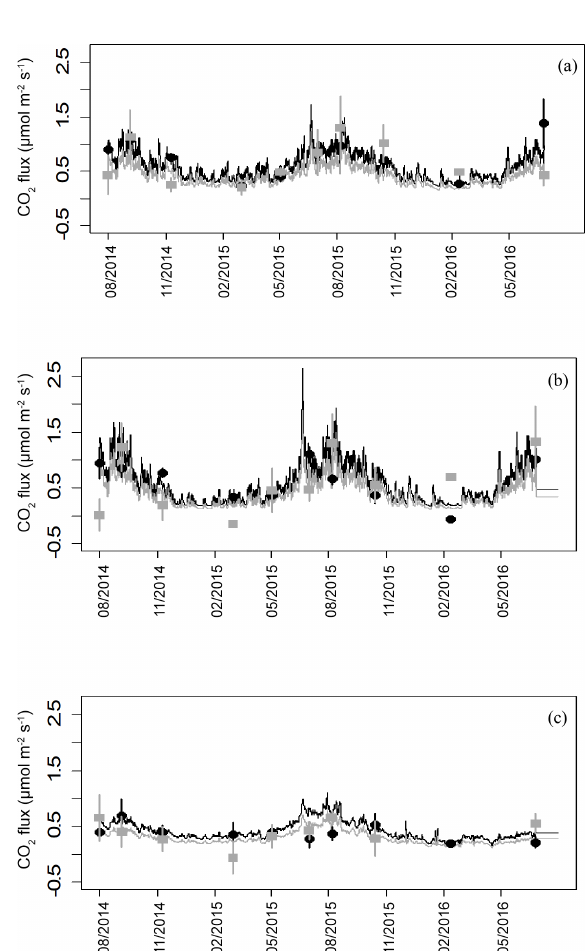
Figure 5. Modelled and measured fluxes of heterotrophic (black) and autotrophic (grey) soil CO 2 efflux from the three topographic microforms. Closed symbols are average fluxes with error bars ( n = 4 plots). Connecting lines are the predicted fluxes using soil temper- ature and moisture at 5cm depth. (a) Original surface, (b) plough throw and (c)